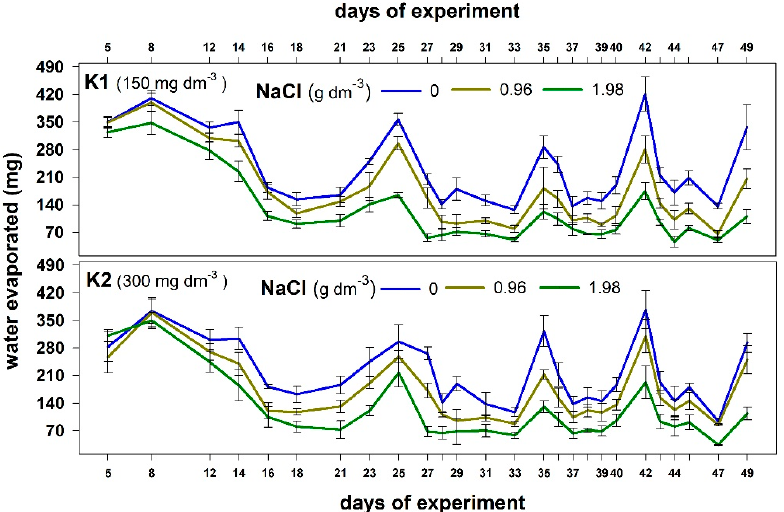
Figure 2. The effect of NaCl doses on water evaporated during the experiment from the containers